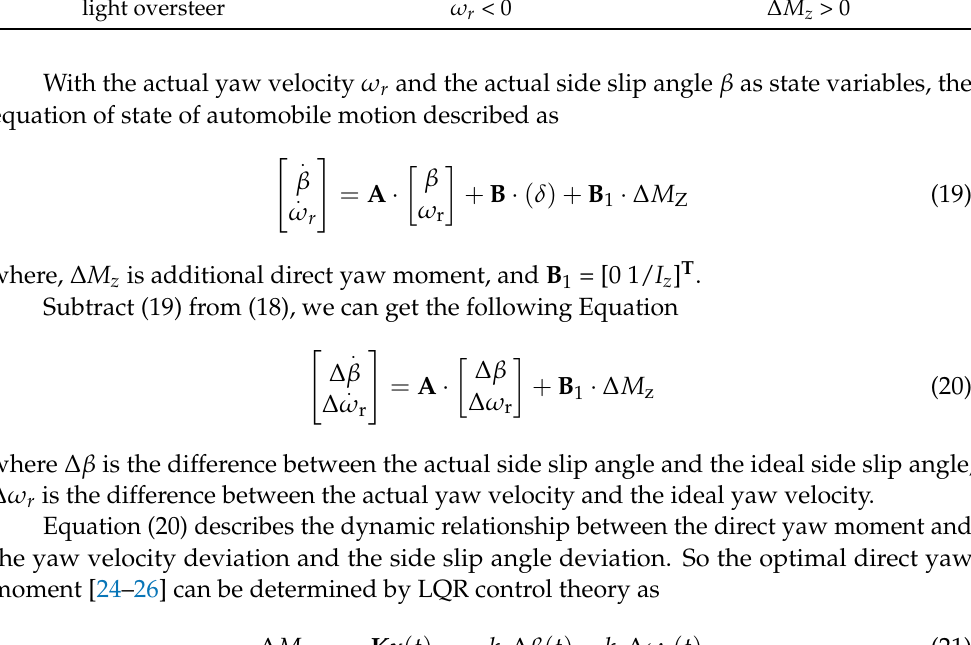
Table 1. Relationship between vehicle steering and additional yaw moment. Steering Condition Yaw Velocity Additional Yaw Moment left understeer ω r > 0 ∆ M z > 0 left oversteer ω r > 0 ∆ M z < 0 light understeer ω r < 0 ∆ M z < 0 light oversteer ω r < 0 ∆ M z > 0